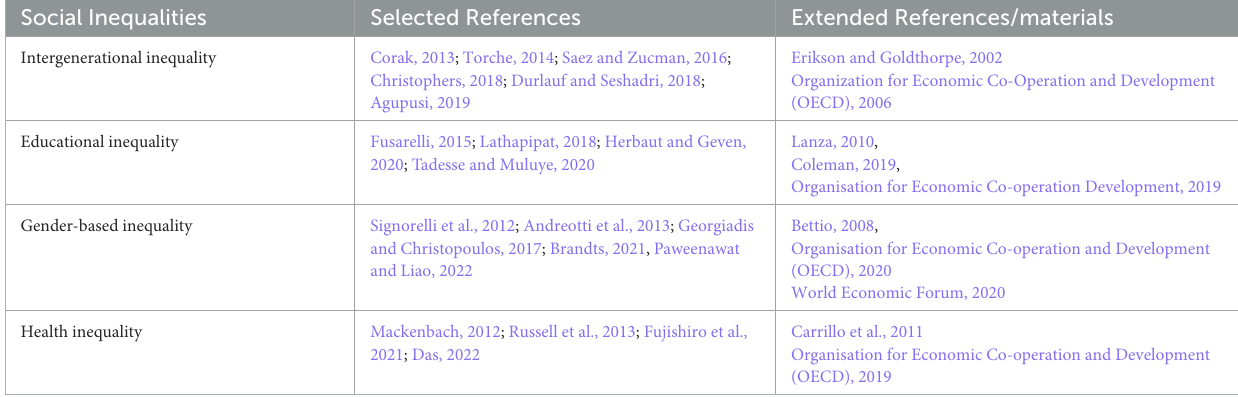
TABLE 2 Summary of selected